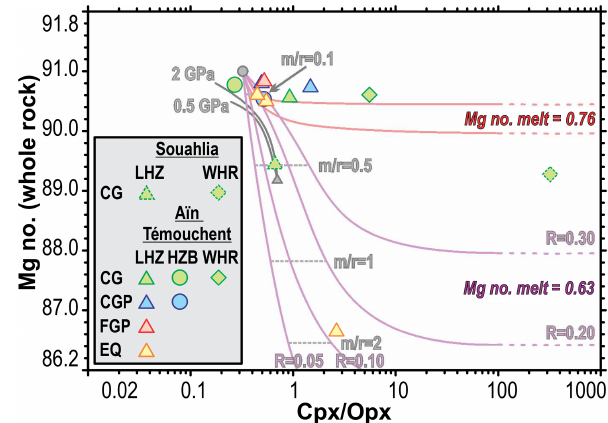
Figure 9. Clinopyroxene / orthopyroxene (Cpx / Opx) ratio of rep- resentative Oran mantle peridotites in the function of their calcu- lated whole-rock Mg no. Data are compared to the results of mod- eling of batch partial melting (grey solid lines) in the range of 0.5– 2.0GPa (Varas-Reus et al., 2016, and references therein) and the variations produced by interaction of a refractory peridotite (Mg no. is 0.91; Cpx / Opx is 0.32) with percolating high-Mg no. (0.76; red solid lines) and low-Mg no. (0.63; purple solid lines) basaltic liquid involving Cpx-forming reactions at decreasing melt mass (Ionov et al., 2005). For the low-Mg no. melt, R values indicate the mass ra- tio of crystallized minerals to infiltrated melt ranging from 0.02 to 0.3, and grey dashed lines denote the melt–rock ( m/r ) ratio. For the high-Mg no. melt composition, all modeling results plot between the red lines. Dashed lines indicate extrapolation from original nu- merical modeling presented in Ionov et al. (2005). See text for fur- ther details and Fig. 2 for abbreviations shown in the